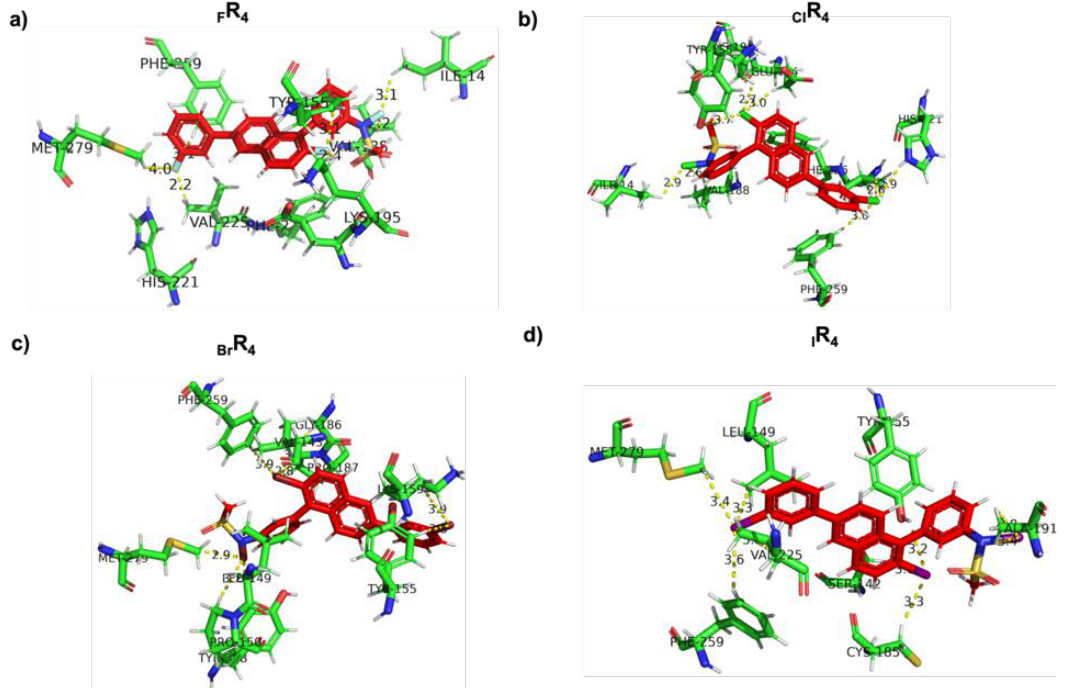
Figure 7. The halogen-bond interactions between 17 β -HSD1 and more potent molecules, such as F R 4 , Cl R 4 , Br R 4 , and I R 4 compounds (( a – d ), respectively). Note: here, the compounds are represented by a red color.